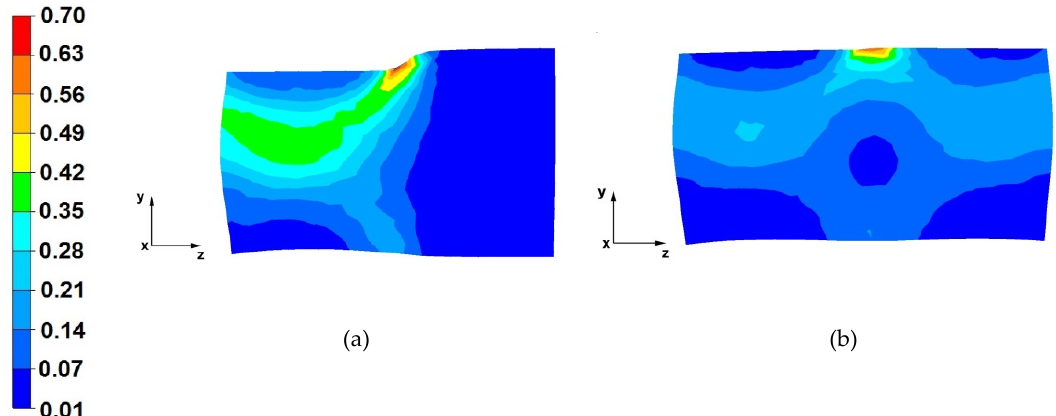
Figure 17. Distribution of the effective strain value on the longitudinal section of the AZ 91 alloy forging, with 25% reduction in trapezoid and diamond anvils, ( a ) forged in the first pass, ( b ) forged in the second pass.